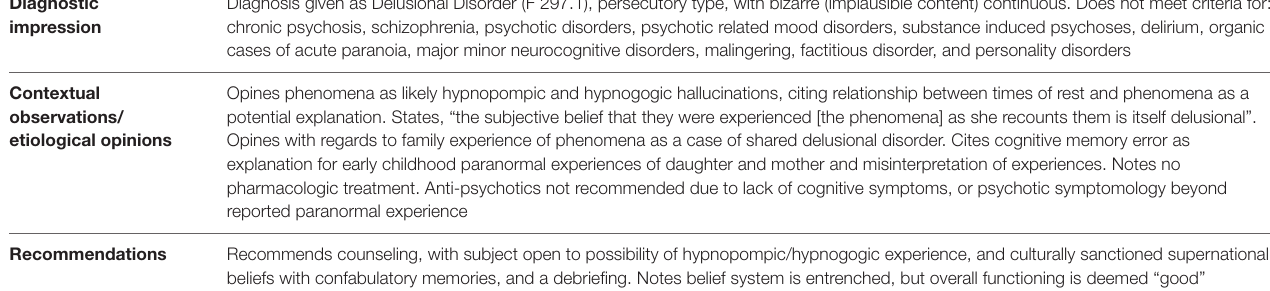
TABLE 1 | Diagnostic impression of the primary percipient per independent assessment (dated 20 March 2020). Diagnostic